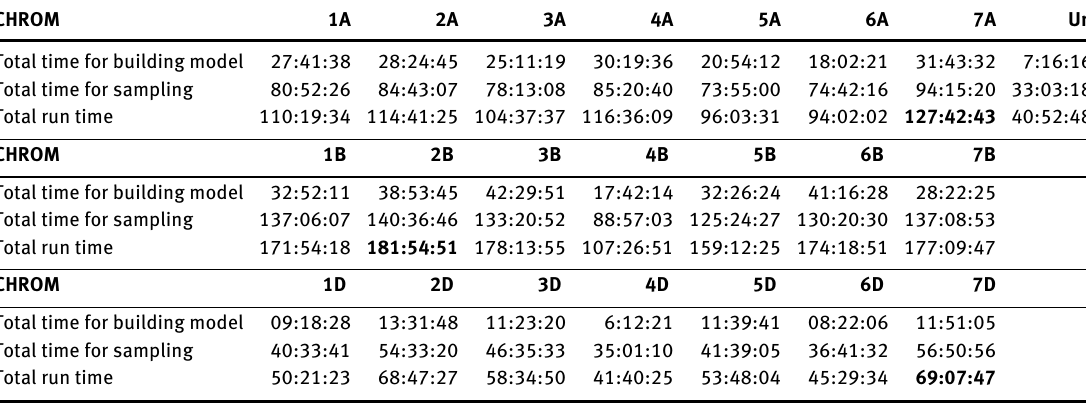
Table 3: Tables with Run times for the different runs over batches of chromosomes on multiple nodes. Test run was executed on two identical virtual machines with 14VCPU and 128 GB RAM. The first two batches (A and B genomes) were submitted to the nodes and the third batch (D genome) submitted as soon as the first of both was completed. The A genome batch also included the SNPs of unknown chromosomes. With three nodes available this is not necessary, so for the total run time this is neglected. Bold written Total Run Times signal, which chromosome imputation was the run time determining